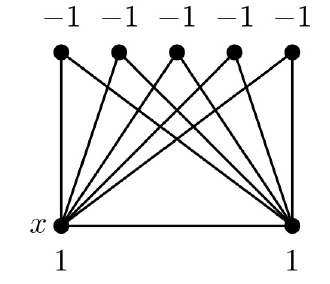
Figure 2. A split graph G with τ s